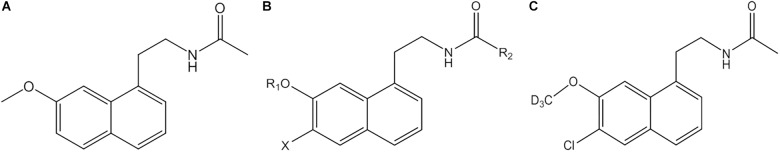
Structure of AGO (A), structure of the series derivatives of AGO (B), and GW117 (C). X are H or halogen atoms; R1 are CH3 or CD3; R2 are CH3, CD3, or C2H5.